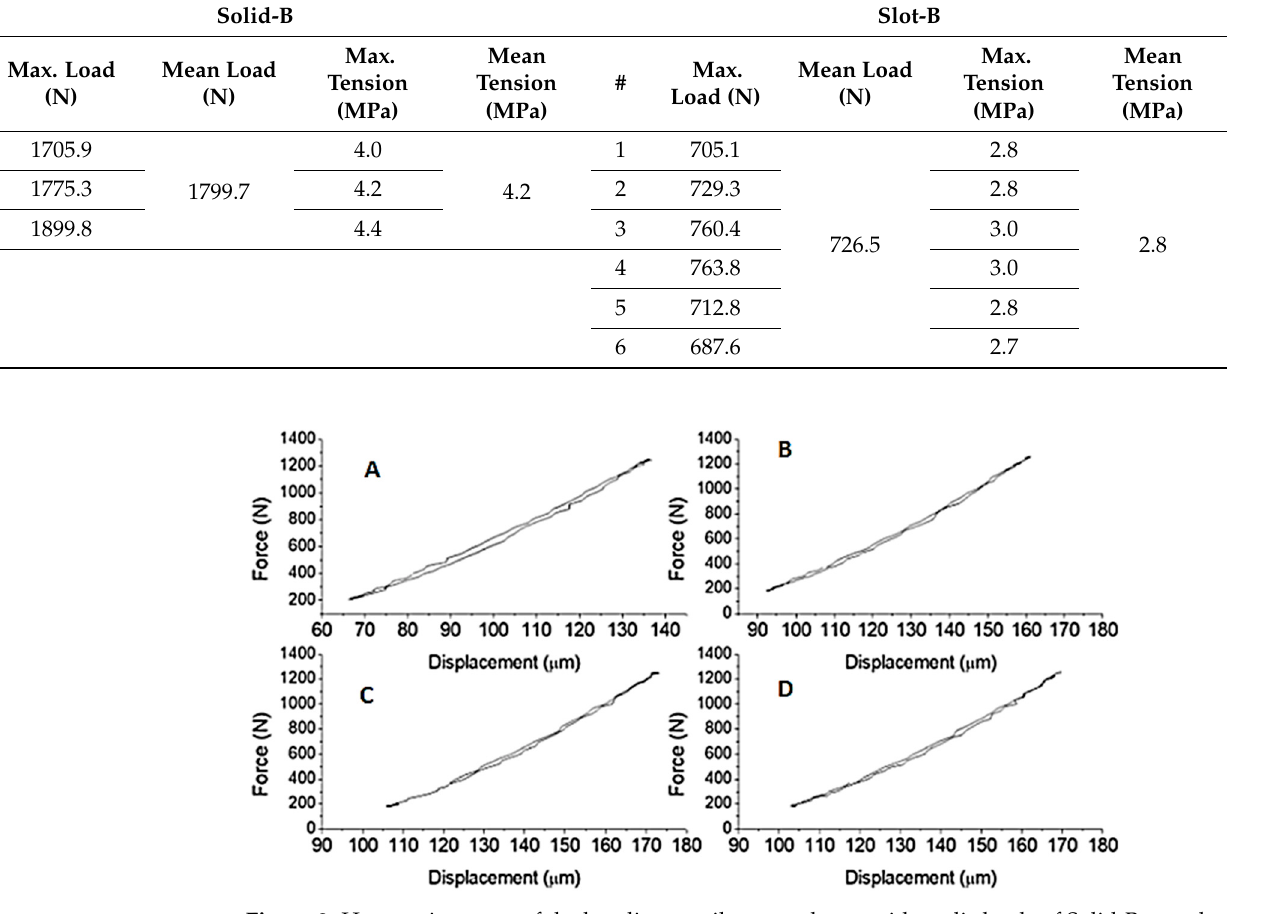
Figure 2. Hysteresis curves of the bending tensile strength test with cyclic loads of Solid-B samples: ( A ) 1000 cycles, ( B ) 2000 cycles, ( C ) 3000 cycles, and ( D ) 4000 cycles.